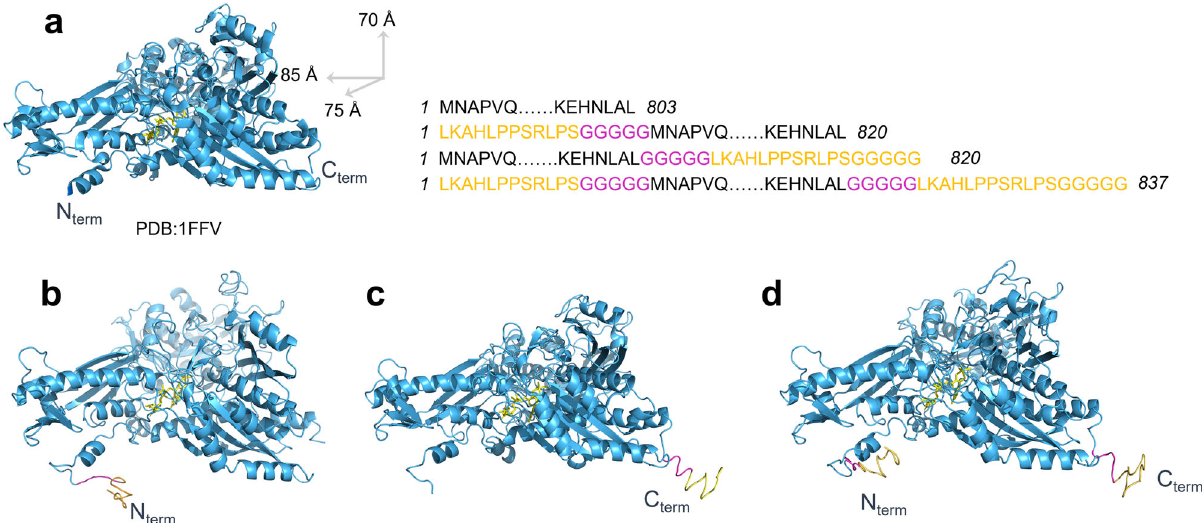
Fig. 2 Native CODH-L and the predicted structures of the synthetic enzymes. The structures of a the native CODH-L, b CODH-L gbpN , c CODH-L gbpC , and d CODH-L gbpNC , with the highest con fi dence value (C-score) predicted by I-TASSER, were aligned followed by structural superposition with the native CODH-L using PyMol.